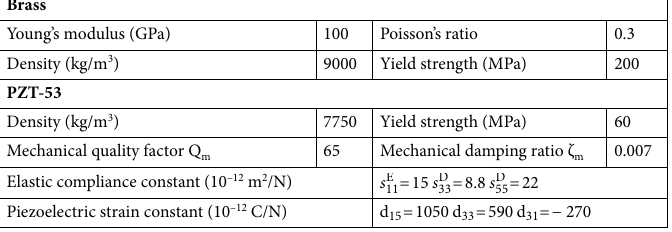
Table 1. The materials properties.